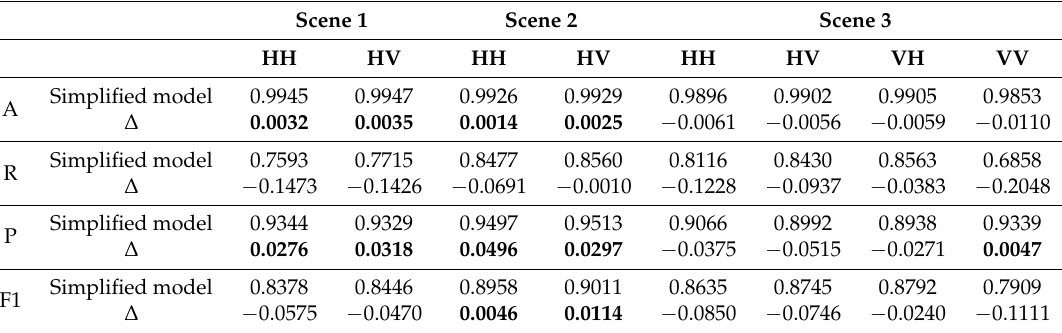
Table 8. Index comparison for FCN16 with and without pooling layer. A is accuracy, R is recall, P is precision, and F1 is F1 score, given in Equation (3). Positive ∆ (in bold) means reducing pooling layer is a better